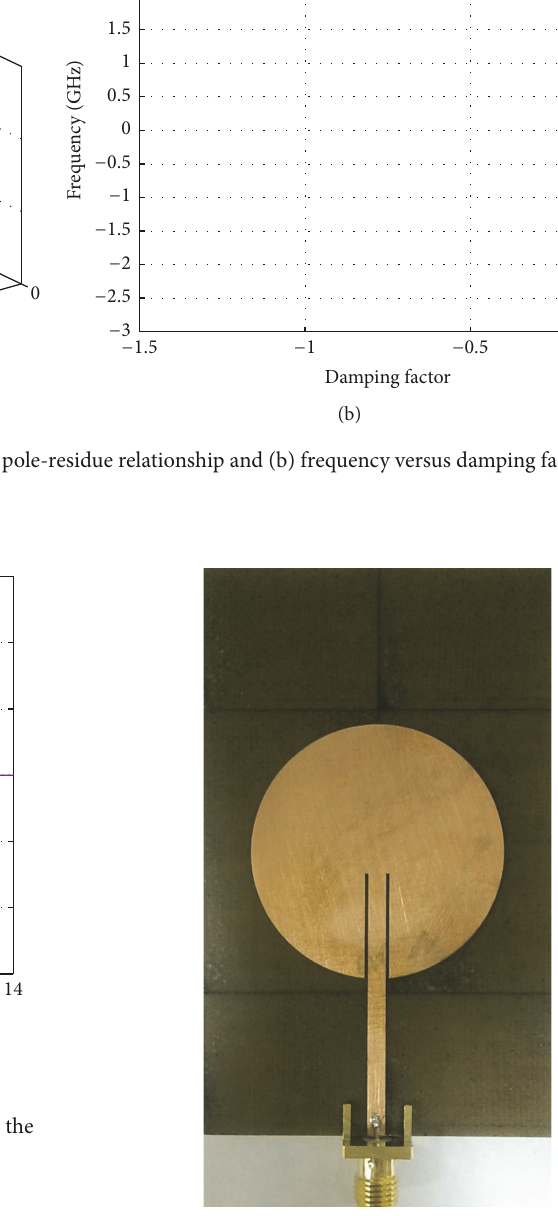
Figure 23: Photograph of single band microstrip